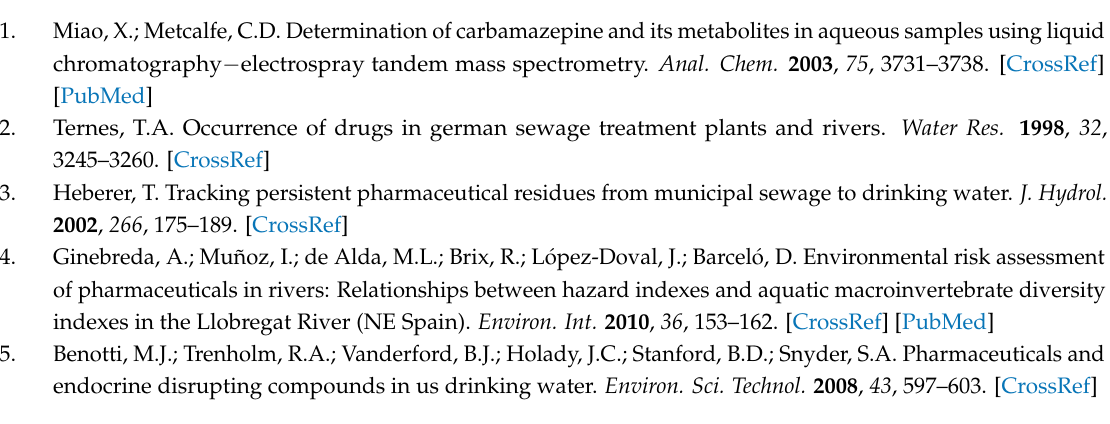
Comparison of CBZ degradation by PMS/BiOBr and PMS/CuFe 2 O 4 , Figure S4: Normalized degradation rate of CBZ based on specific surface area for PMS/BiOBr, Figure S5: Color change of BiOI suspension during the degradation process, Figure S6: XRD spectra of BiOBr particles before and after the repeated catalytic PMS oxidation (7 cycles), Figure S7. Effect of leaching bismuth ion on the degradation of CBZ, Figure